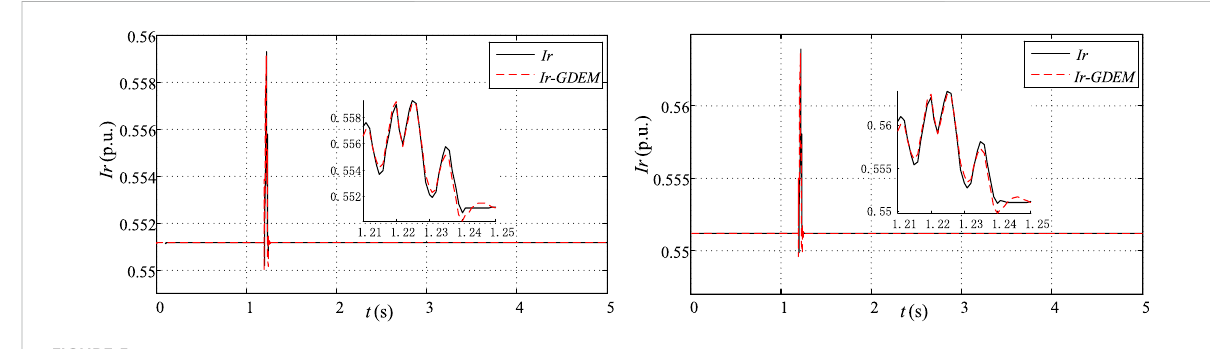
Dynamic characteristic response of the real part of the current with F1 and F2 in operating condition 1.